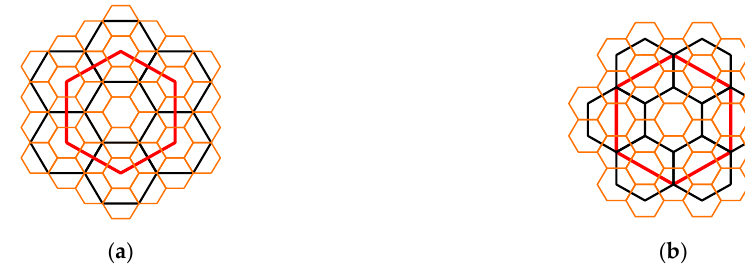
Figure 5. Diagram of mixed aperture 3 and 4: ( a ) aperture sequence 34; ( b ) aperture sequence 43. The red cells are the initial cells at level 0; the black cells belong to level 1; the orange cells belong to level 2 (source—own study).